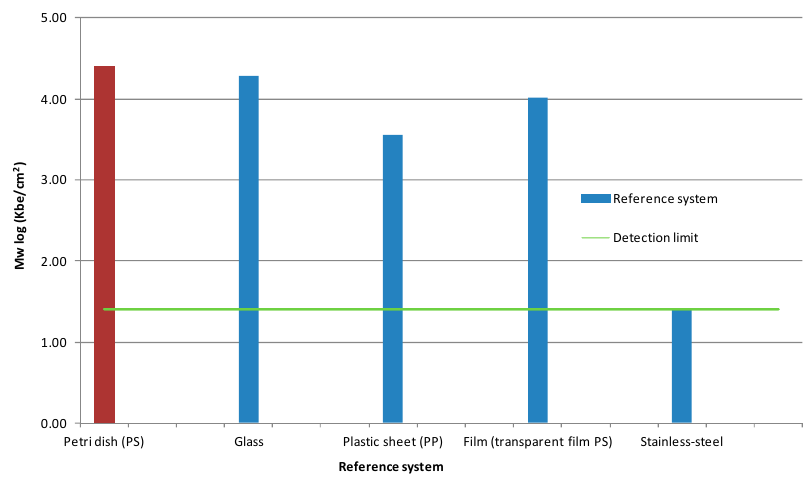
Figure 3. Antimicrobial activity (log Kbe mL − 1 ) of different blank surfaces (used as reference systems)